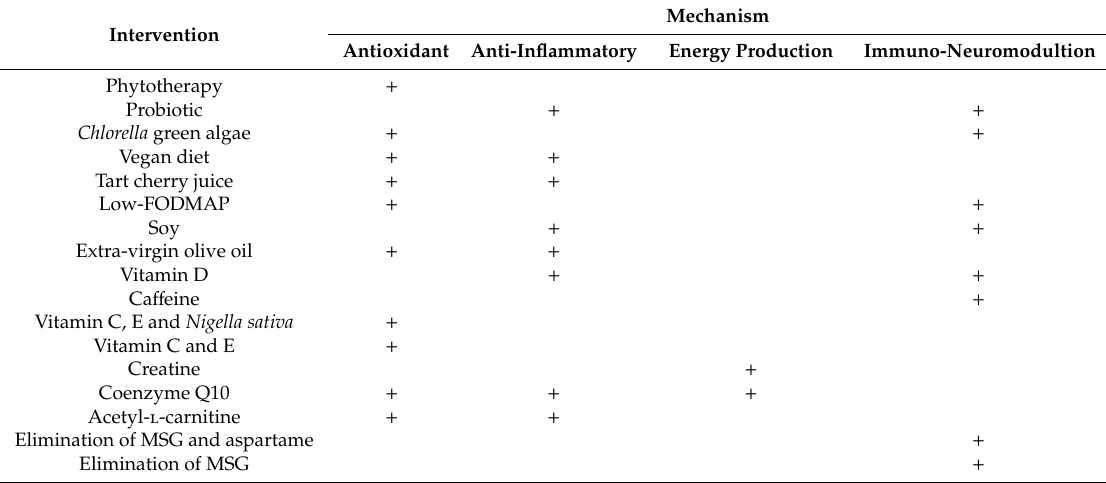
Table 4. Hypothesised physiological